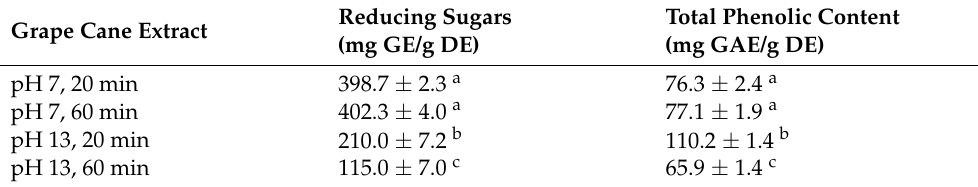
Table 1. Reducing sugars and total phenolic content in “Greco” grape cane dry extracts. Grape Cane